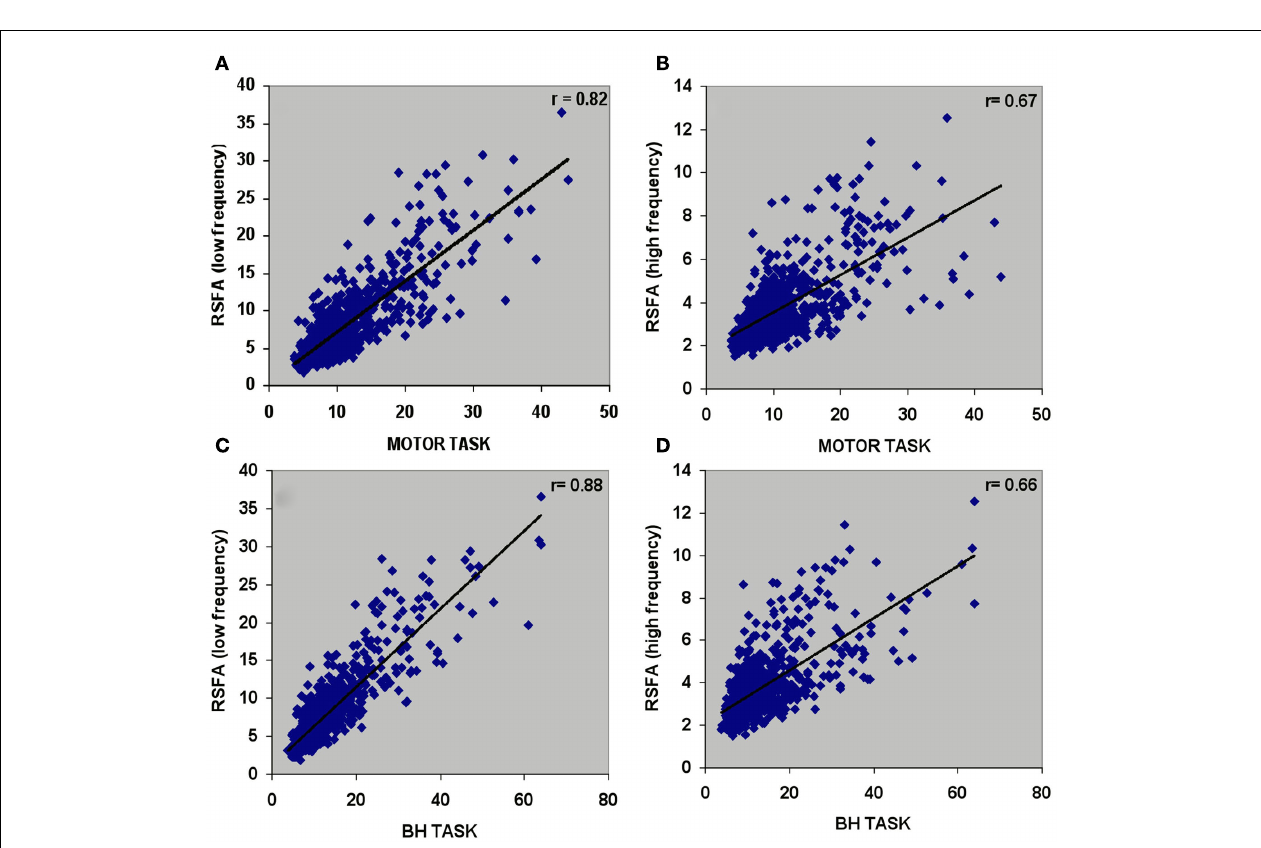
FIGURE 3 | (A) Voxel-level relationship between motor vs BH ( r = 0.91; P < 10 − 7 ) and (B) motor vs RSFA ( r = 0.84; P < 10 − 7 ).Voxels were derived after cross correlating the BOLD response time courses with the gamma-variate